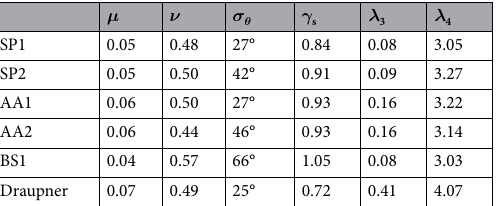
Table 2. Sea state parameters during the stereo acquisitions, and for the Draupner event. Mean spectral wave steepness: μ ; spectral bandwidth parameter: ν ; one-sided directional width: σ θ ; short-crestedness parameter: γ s ; skewness coefficient: λ 3 ; kurtosis coefficient: λ 4